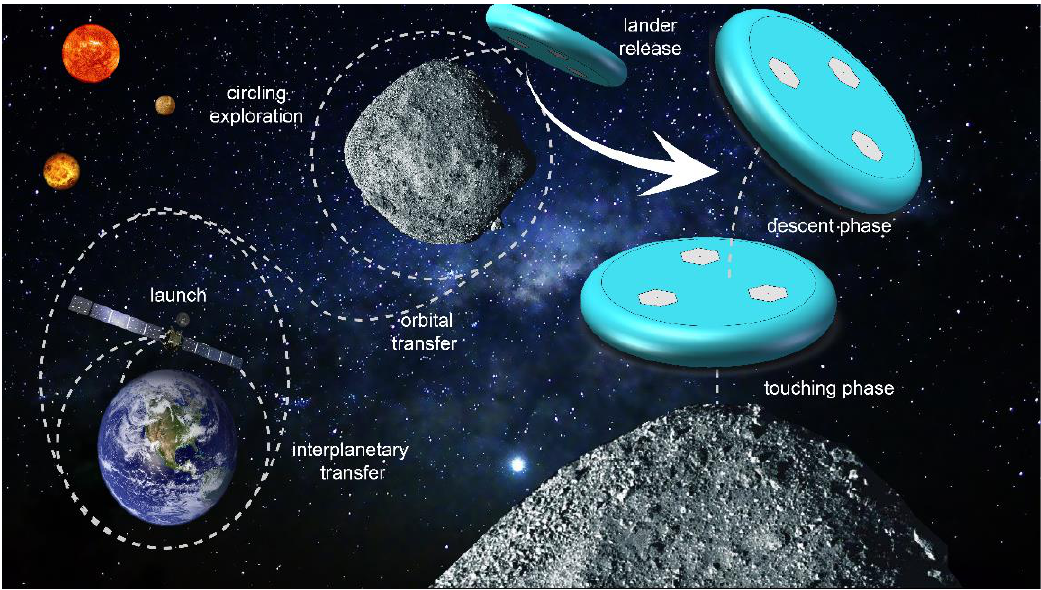
Figure 2. The concept of the asteroid exploration mission using the flexible lander.